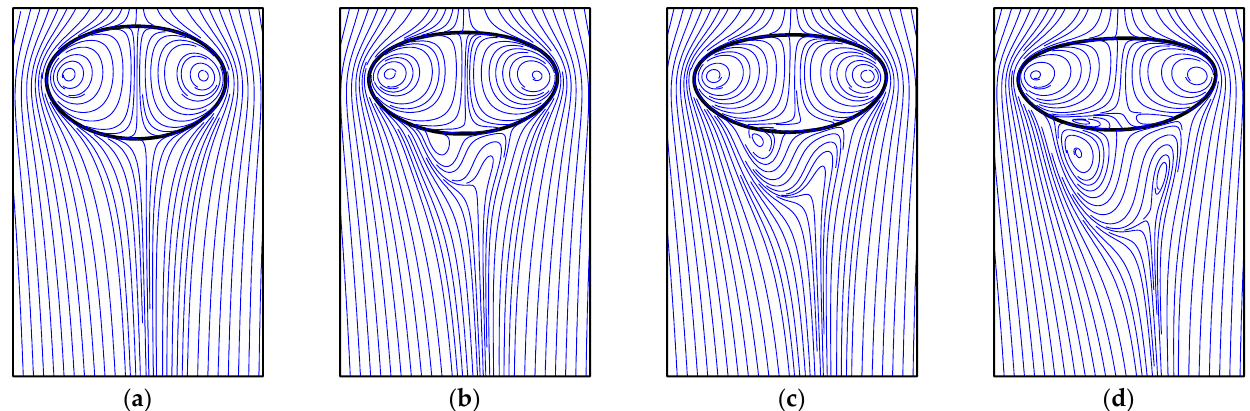
Figure 14. Streamlines ( u – U ) in x - z plane: right side is inside gap. ( a ) Case 8N ( b ), case 9N ( c ), case 10N ( d ), case 11N. Flow direction behind bubble is from outside to inside.